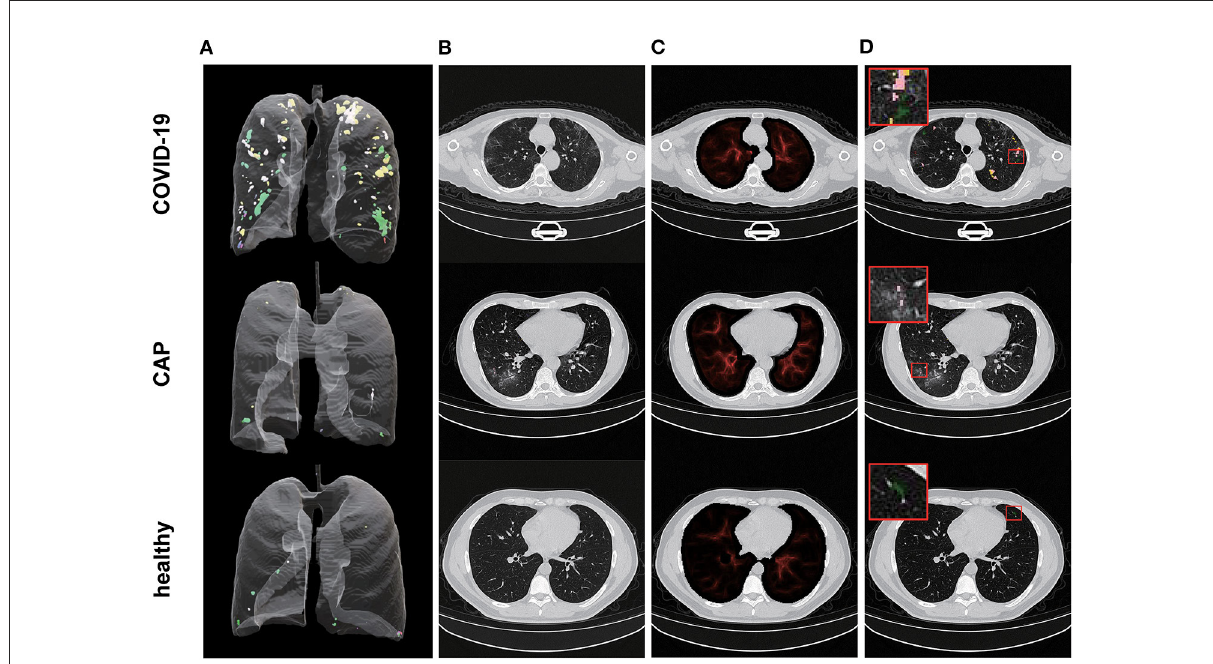
FIGURE4 Illustration of representative CT image and the corresponding vasculature-structure enhancement and multi-spectral staining in COVID-19, CAP and healthy samples. (A) Representative examples for 3D multispectral imaging biomarker visualization (3D animations are provided by Supplementary Videos 4–6); (B) Representative 2D CT images; (C) Corresponding 2D vasculature-structure enhancement (enhancement for entire chest CTs are provided by Supplementary Videos 1–3); (D) Corresponding 2D multi-spectral staining (2D multi-spectral staining for entire chest CTs are provided by Supplementary Videos 7–9).